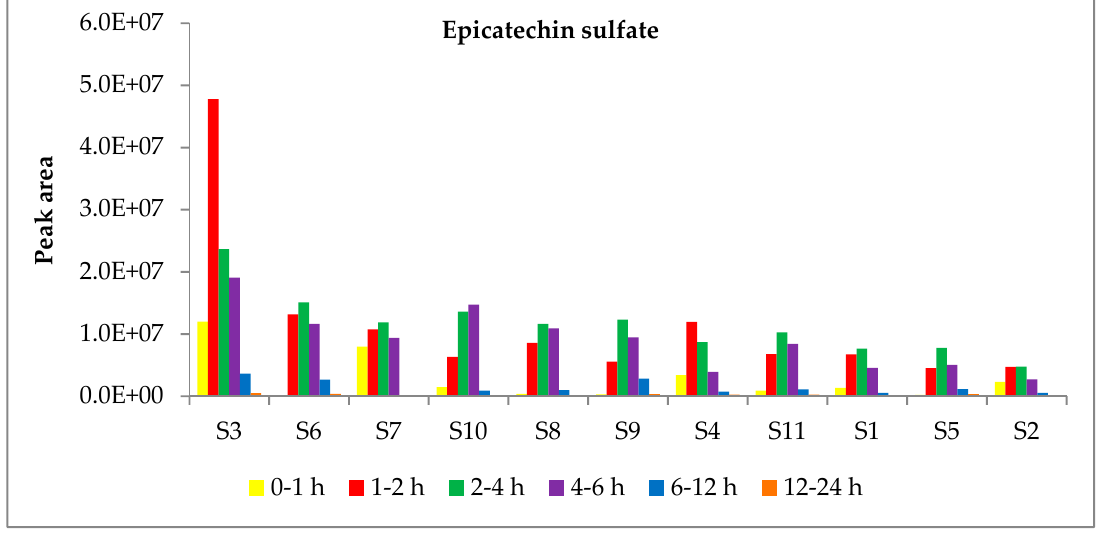
Figure 4. Excretion of epicatechin sulfate in urine in the 11 study participants (S1–11). 0–1 h: yellow bars; 1–2 h: red bars; 2–4 h: green bars; 4–6 h: purple bars; 6–12 h: blue bars; 12–24 h: orange bars. Subjects were shown in decreasing order according to the AUC in the range T1–T24.